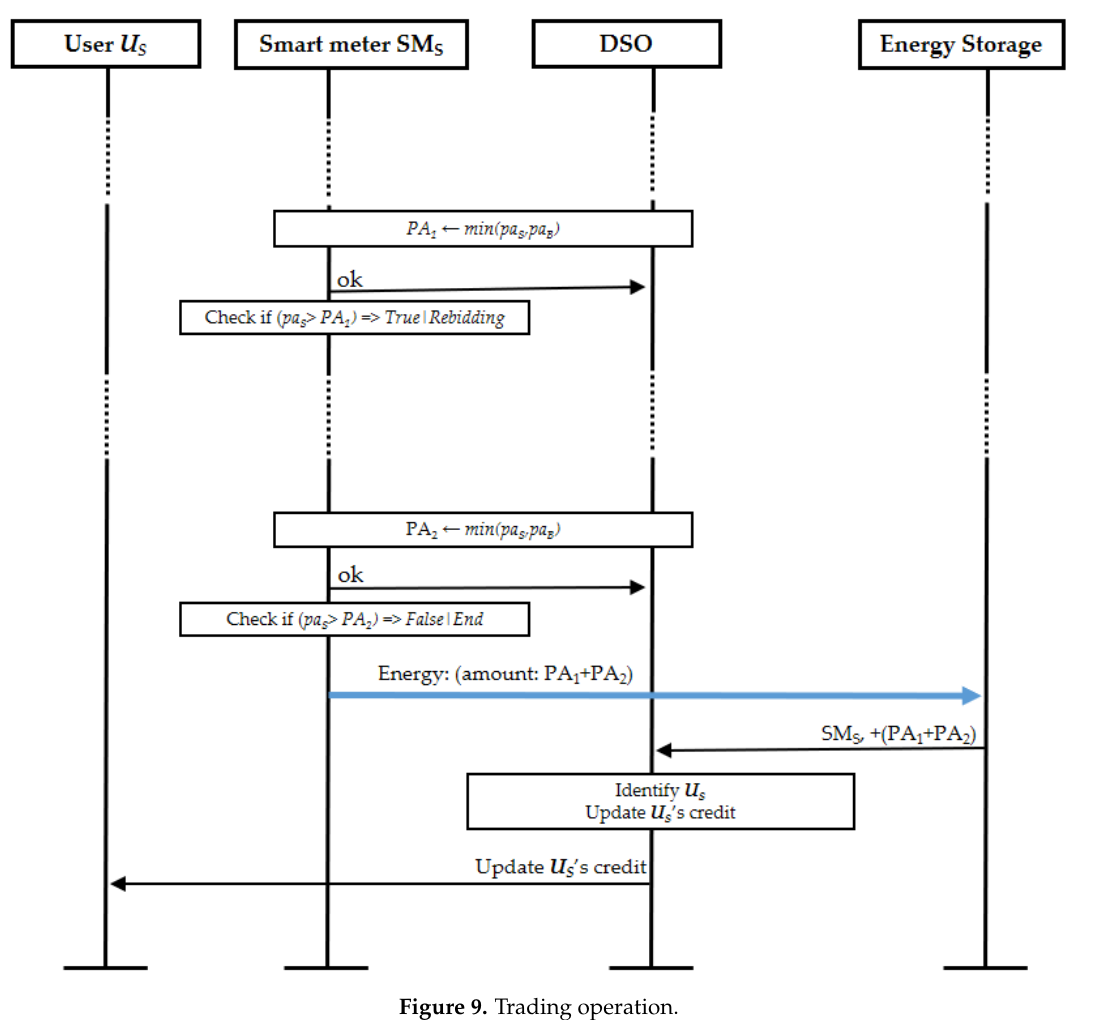
Figure 9. Trading